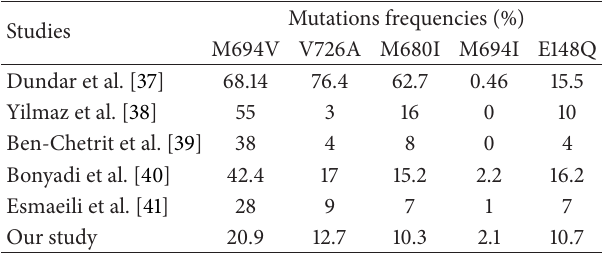
Table 4: Comparison of different genotypes studies.